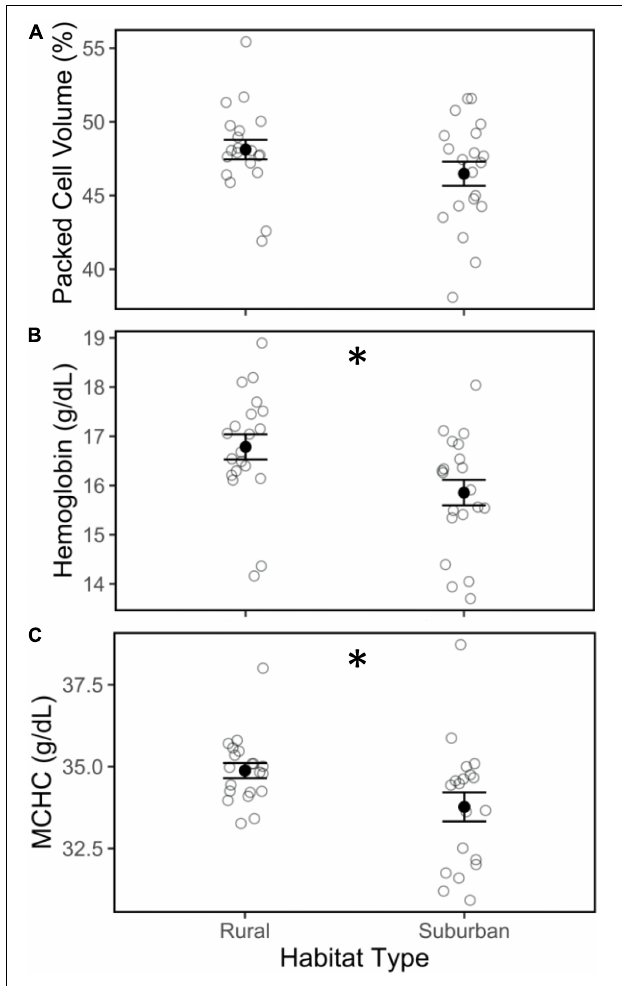
FIGURE 2 | Packed cell volume (PCV; A ), total hemoglobin concentration (B) , and mean corpuscular hemoglobin concentration (MCHC; C ) in blood collected from male song sparrows inhabiting rural and suburban sites. Closed circles and whiskers are mean ± SE; open circles are measurements of individuals birds; asterisk denotes difference at p < 0.05.